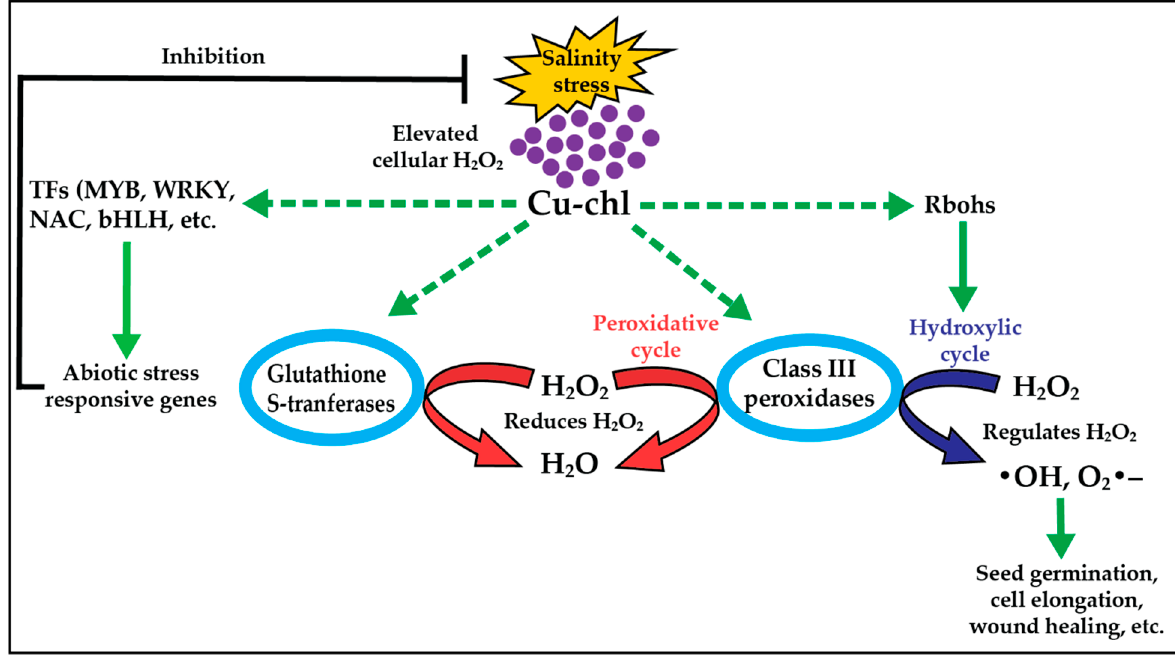
Figure 8. Mechanism of Cu-chl mediated oxidative stress regulation under salinity stress. Application of Cu-chl induces the expression of class III peroxidases, Glutathione S-transferase , Rbohs and TFs under salinity stress. Upon stimulation, class III peroxidases and glutathione S-transferases activate the peroxidative cycle and reduce H 2 O 2. On the other hand, through Rbohs, Cu-chl activates the hydroxylic cycle, thereby producing •OH and O 2 • – from H 2 O 2 to help in cell growth. Solid and dashed green pointed lines, respectively, indicate the genes and mechanisms found in our RNA-Seq data and in previous studies.